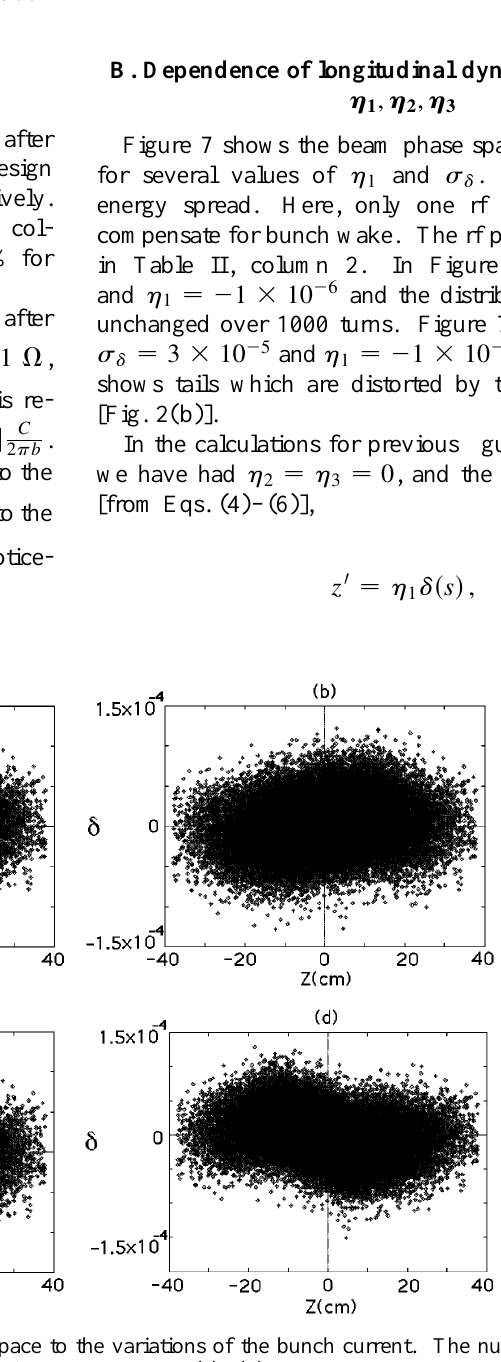
j (cid:173) (cid:48)(cid:46)(cid:49) V (cid:110) (cid:104)